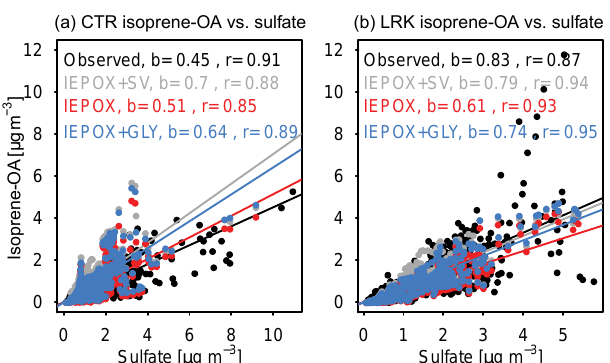
Figure 6. Isoprene-OA vs. sulfate at (a) CTR and (b) LRK and the slope ( b , forced through 0) and correlation coefficient ( r